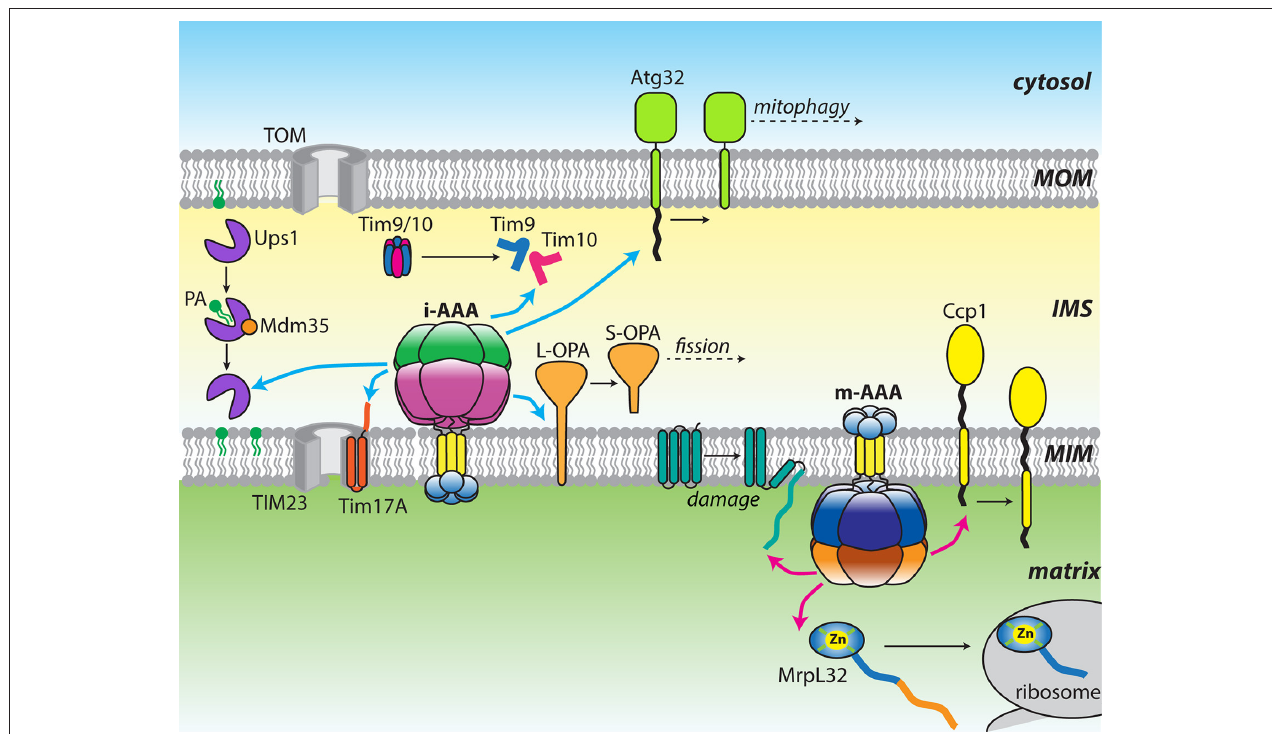
FIGURE 1 | Diverse functions of the mitochondrial AAA proteases. Cartoon showing a diverse array of substrates targeted by either yeast or mammalian i-AAA (cyan arrows) and m-AAA (pink arrows) proteases. Changes in substrate structure or arrangement are shown as black